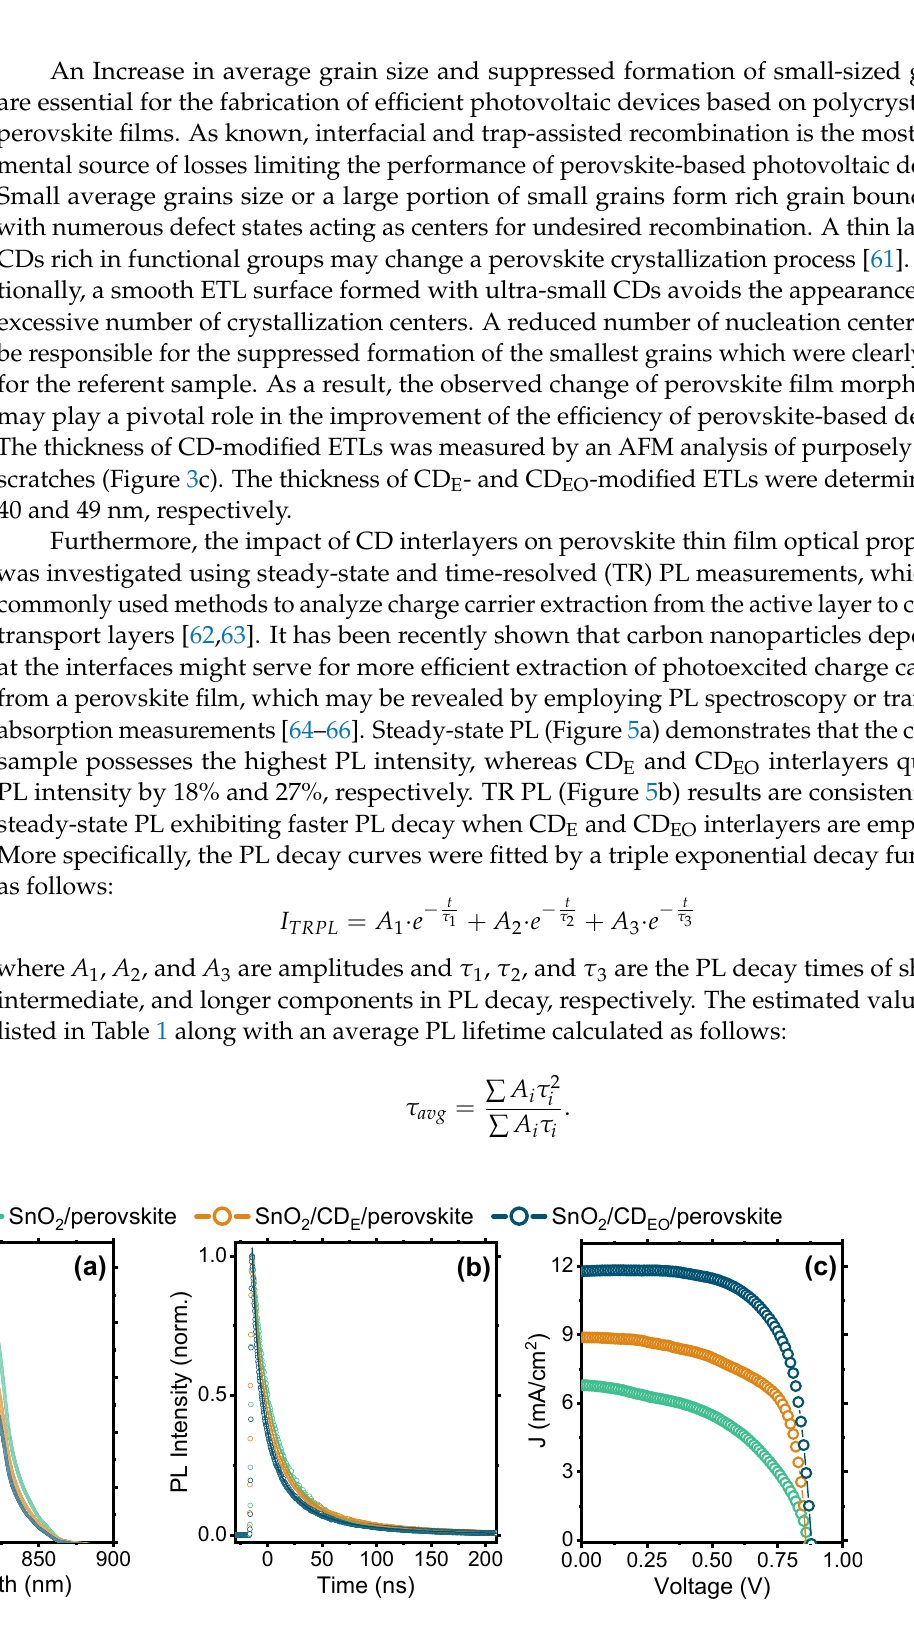
Figure 5. ( a ) Steady-state PL spectra, ( b ) PL decay curves, and ( c ) J-V curves of ITO/SnO 2 /Perovskite, ITO/SnO 2 /CD E /Perovskite, and ITO/SnO2/CD EO /Perovskite photovoltaic devices. Table 1. PL decay parameters for SnO 2 /Perovskite, SnO 2 /CD E /Perovskite, and SnO 2 /CD EO /Perovskite fi lms.